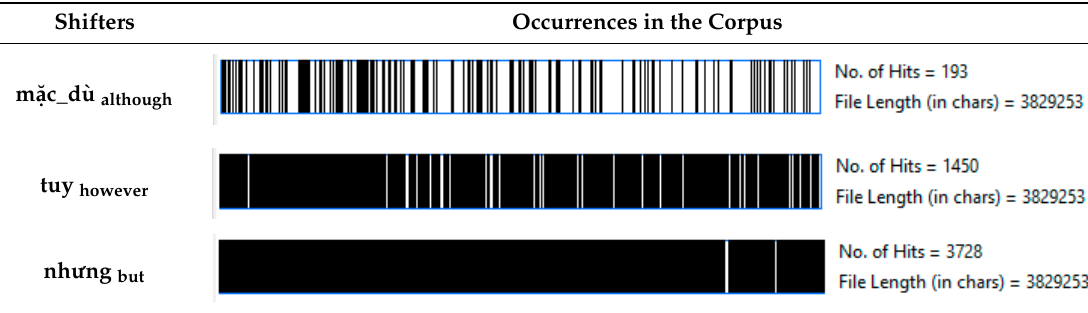
Table 4. Statistics based on some contrast structure words occurring in Vietnamese language corpus of hotel reviews.